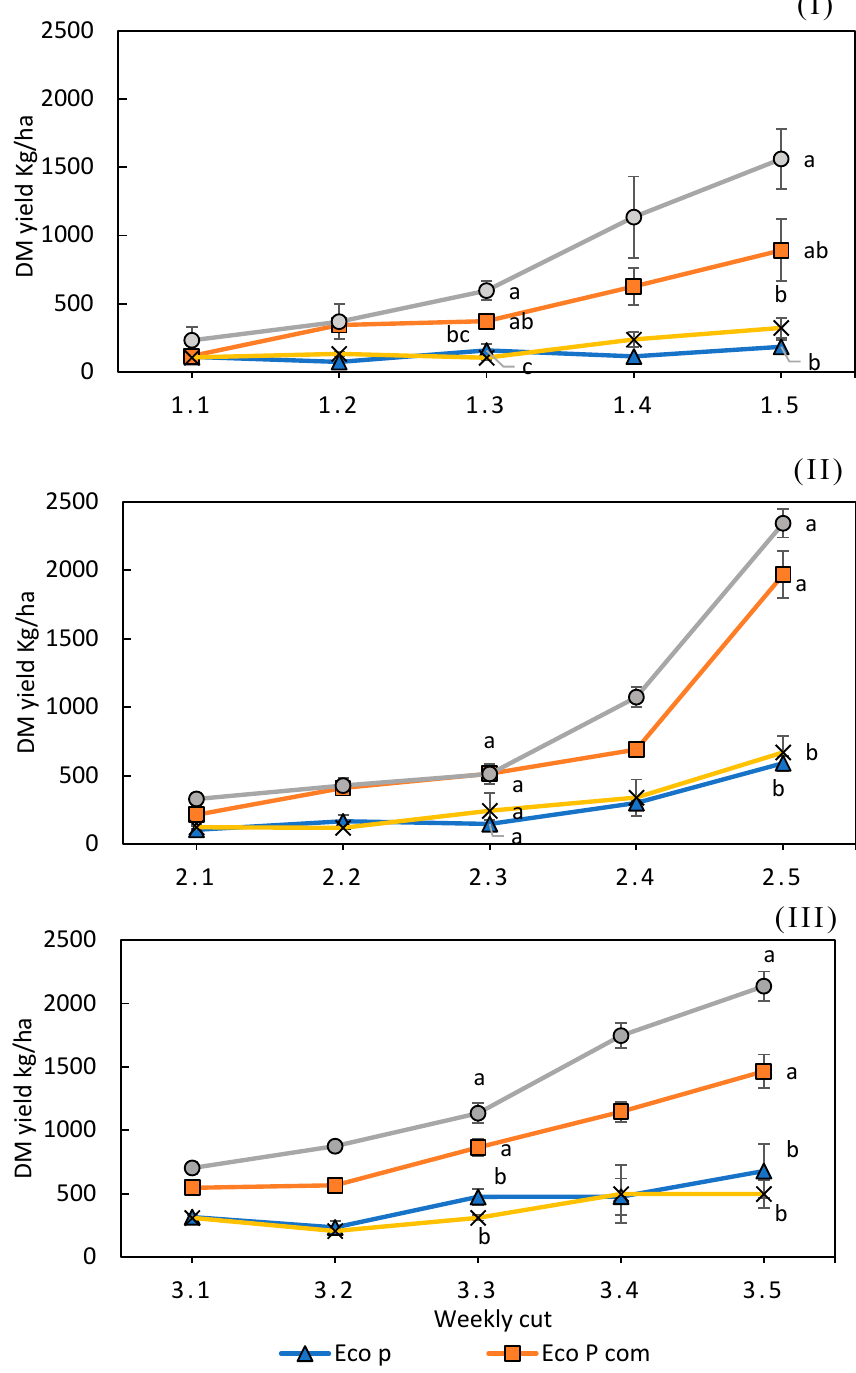
Figure 3. Second-year (2019) weekly growth measurements for inter harvest growth periods one to three ( I – III ). Statistical analyses are presented for weeks 3 and 5, with no statistically significant difference occurring between treatments sharing the same letter ( p > 0.05); error bars indicate standard error.